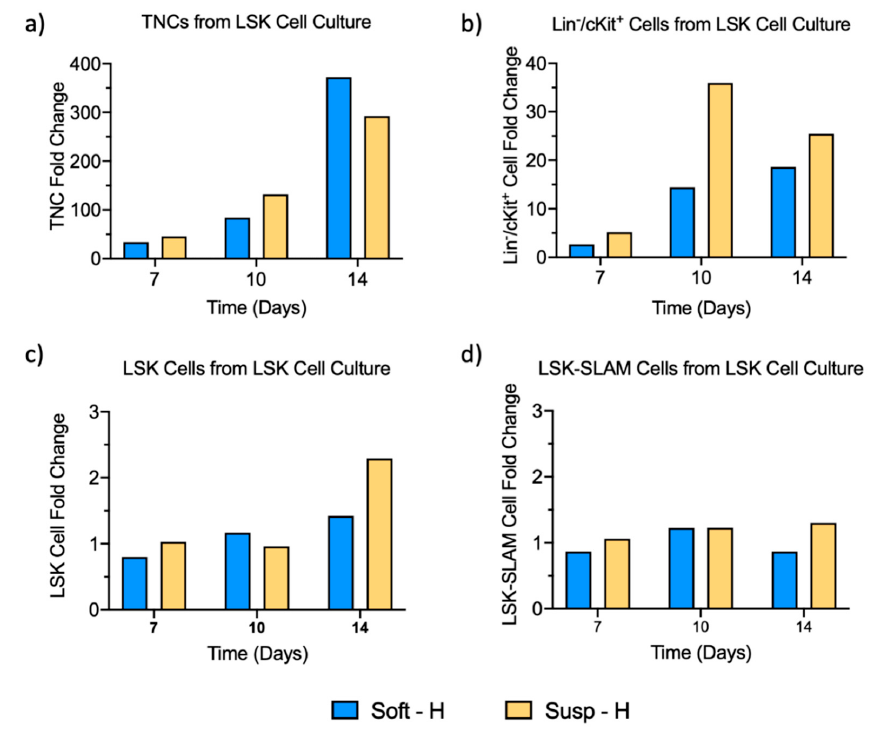
Figure 4. Quantification of HSPC subgroups from LSK-enriched cell culture, retrieved from soft fibrin hydrogels and suspension culture (Susp) under hypoxic conditions (H) over a period of 14 days, shown as fold changes of ( a ) TNCs, ( b ) Lin − / cKit + cells, ( c ) LSK cells, and ( d ) LSK-SLAM cells: Data were acquired from 1 biological sample (pool of 6 donor mice). Given the rapid proliferation observed, cells were harvested on day 7, and the expanded cells were re-cultured under the initial cell conditions for another 7